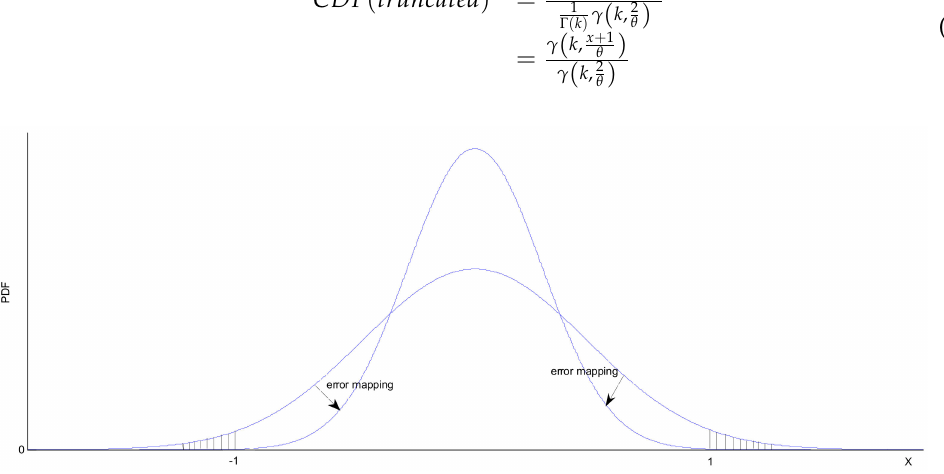
Figure 3. Error mapping for some solutions out of the decision